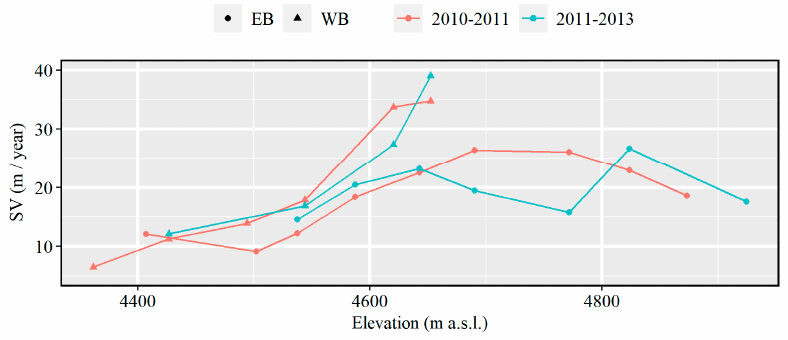
Figure 9. Surface velocities of LHG12 during 2010–2013 (EB: east branch; WB: west branch).